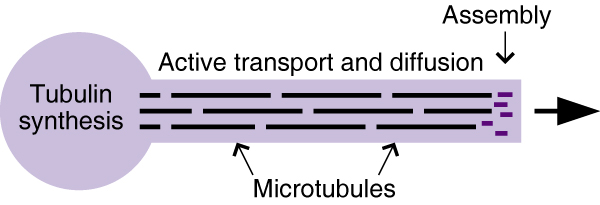
Neurite elongation. Construction of the microtubule cytoskeleton is a rate-limiting factor in neurite elongation. The rate of construction is determined by the production and transport of tubulin along a neurite, and the assembly of tubulin onto the ends of microtubules at the neurite tip.